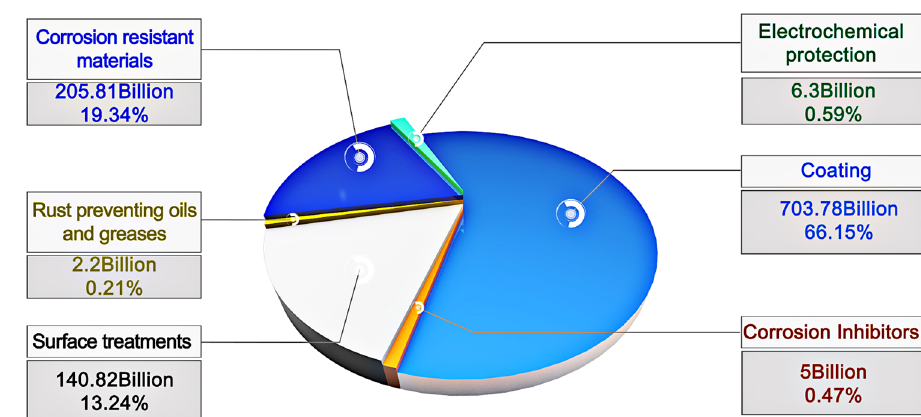
Fig. 1 The direct costs of corrosion in China in 2014. Values listed provide cost of corrosion persection in RMB, and the associated percentage of the total cost of corrosion (Uhlig